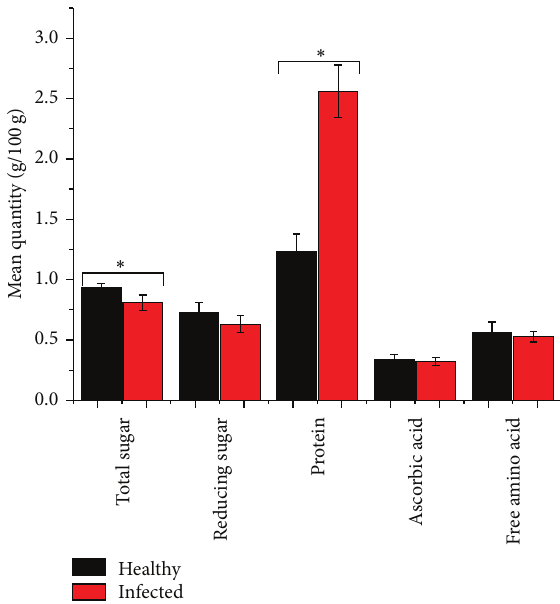
Figure 1: Quantification of primary metabolites (g/100g) in healthy and infected stem bark of mango suffering from quick decline dis- ease. Each bar represents mean ± SD contents of the specific primary metabolite as indicated. ∗ indicates that there was a statistically significant difference between healthy and infected sample at 95%